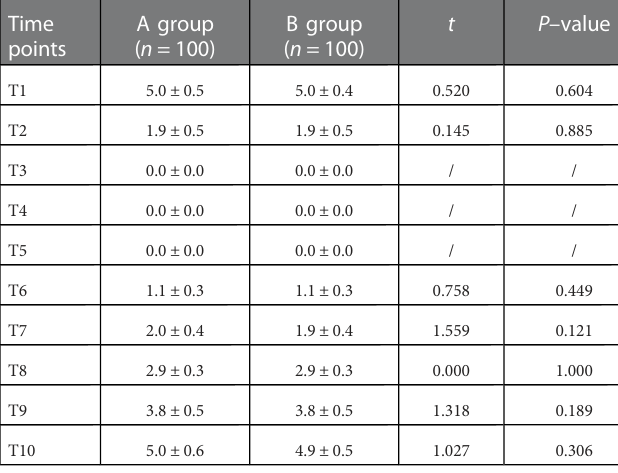
TABLE 2 Comparison of Numerical rating scale anal pain scores.